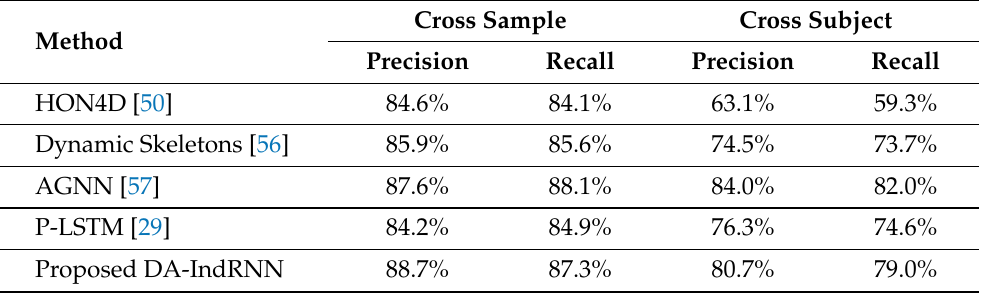
Table 2. Results on Large-Scale Combined (LSC)